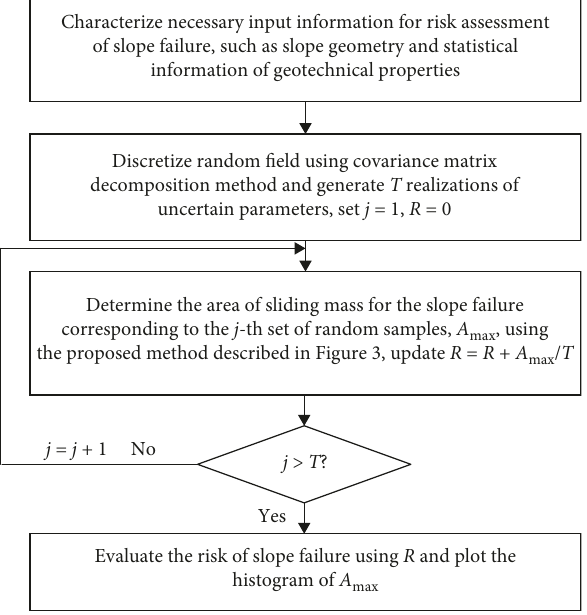
Figure 4: Flowchart of risk assessment of slope failure using proposed method.